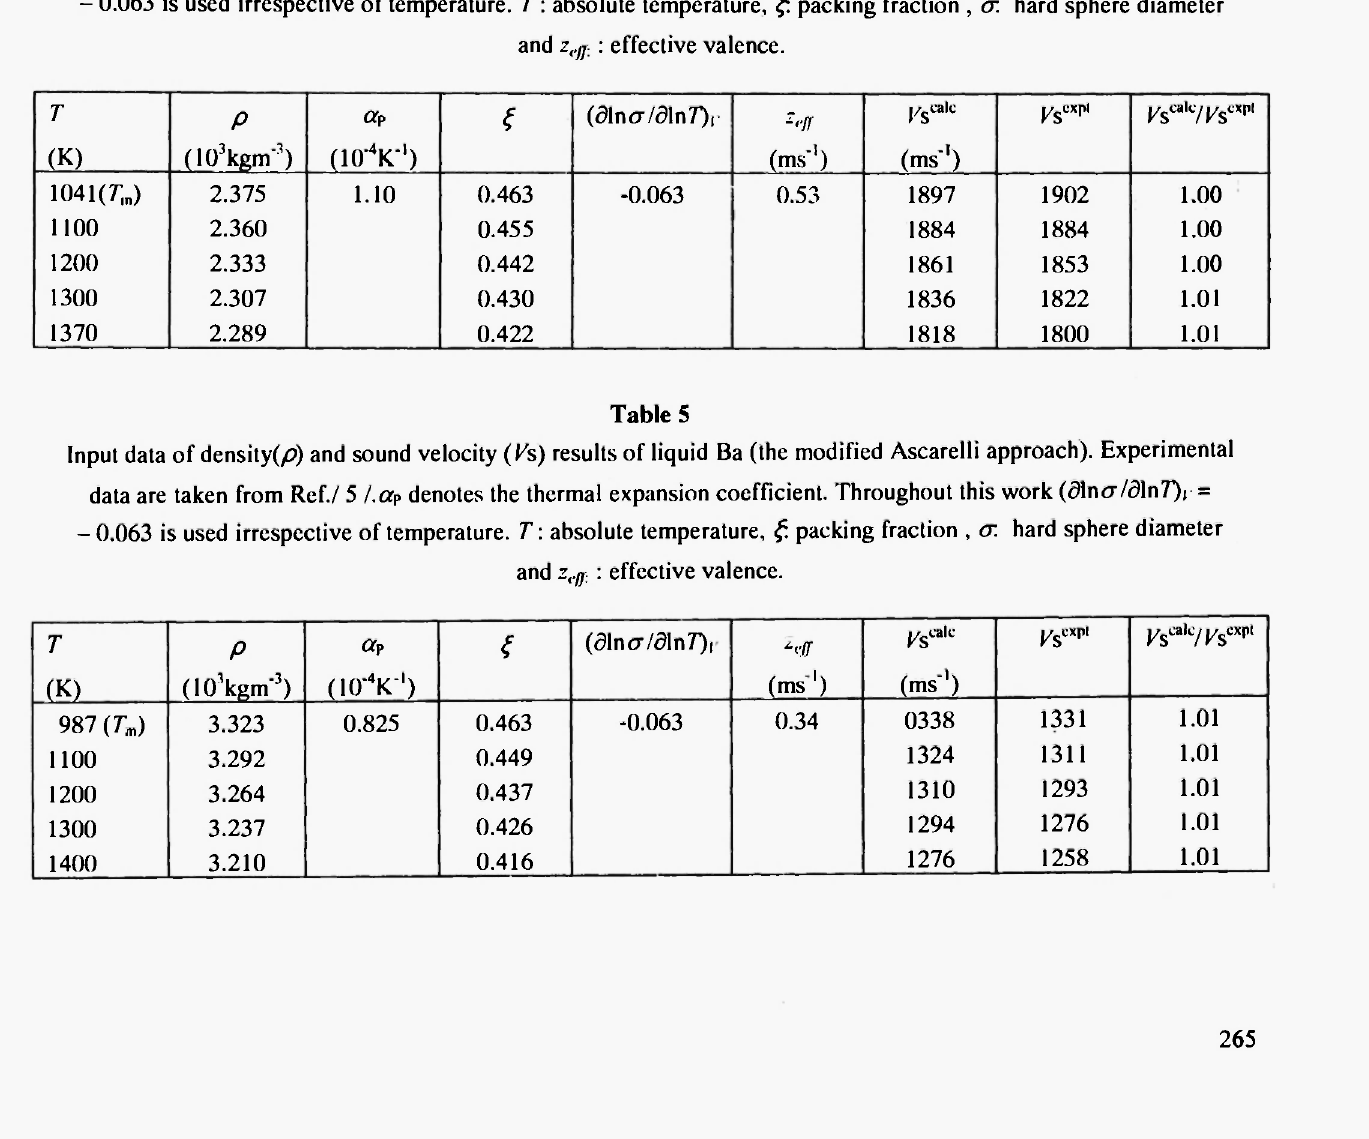
Input data of densityO?) and sound velocity (Ks) results of liquid Sr (the modified Ascarelli approach). Experimental data are taken from Ref./ 5 /.« P denotes the thermal expansion coefficient. Throughout this work (<91ησ/01η7")ι = - 0.063 is used irrespective of temperature. Τ : absolute temperature, ξ. packing fraction , σ. hard sphere diameter and z ,. JJ : effective valence.